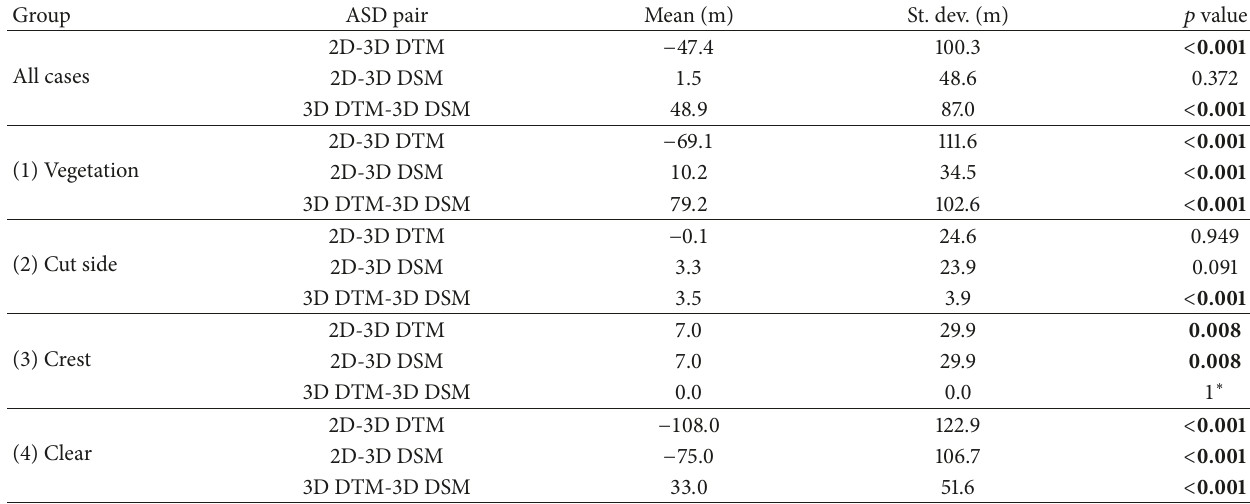
Table 3: Comparison of ASD values among the three